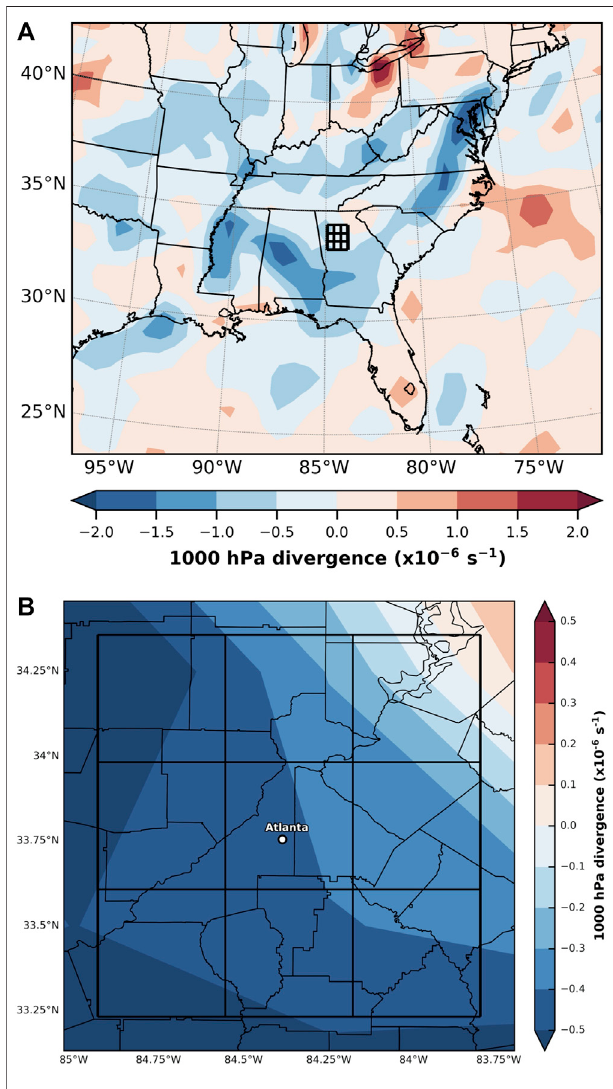
FIGURE 10 | Composite anomaly map of 1,000 hPa divergence for URDs compared to non-URDs across the Southeast region (A) and the metropolitan Atlanta area (B) . The 9-cell gridded framework centered on Atlanta is indicated by the black-outlined